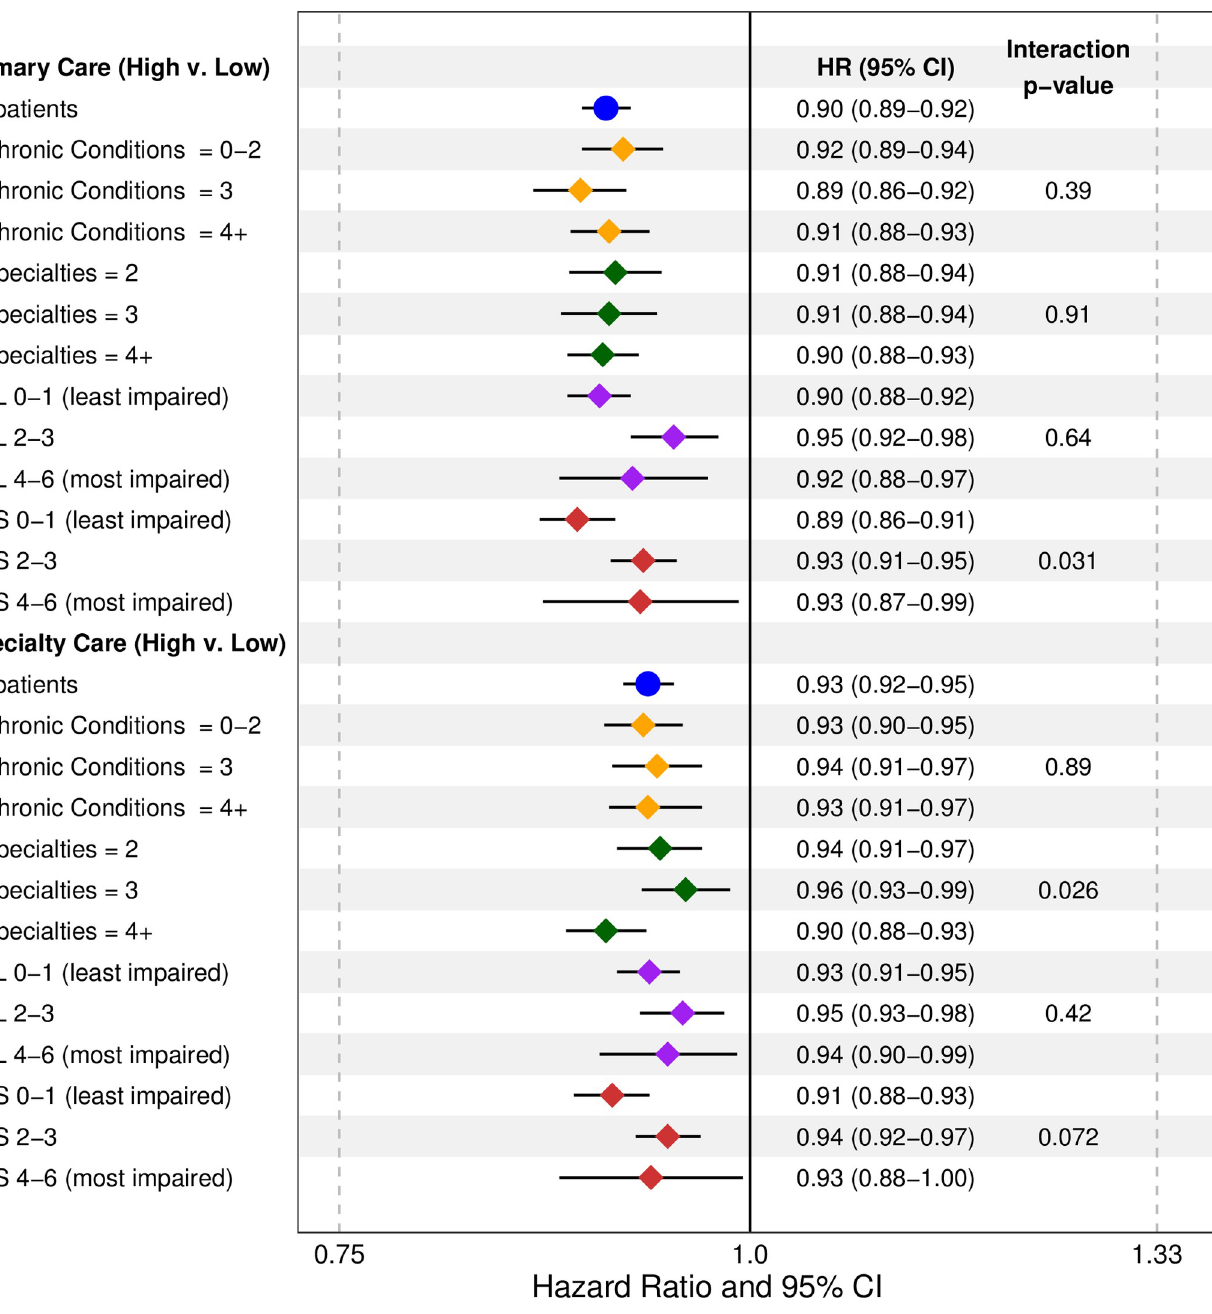
PLOS ONE | https://doi.org/10.1371/journal.pone.0258708 October 12, 2021 2 /